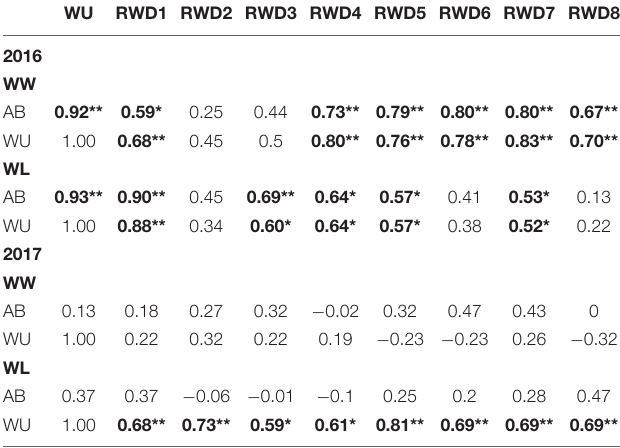
The correlations were calculated within each water regime using the genotype values of the three replicates (n = 15). WW, well-watered, WL, water-limited. Probabilities (*P ≤ 0.05; **P ≤ 0.01) are shown. The number following the acronym of the trait refers to the soil column depth where the trait was measured: 1 refers to 0–20 cm; 2 refers to 20–40 cm; 3 refers to 40–60 cm; 4 refers to 60–80 cm; 5 refers to 80–100 cm; 6 refers to 100–120 cm; 7 refers to 120–140 cm; 8 refers to 140–160 cm. Bold numbers represent significant